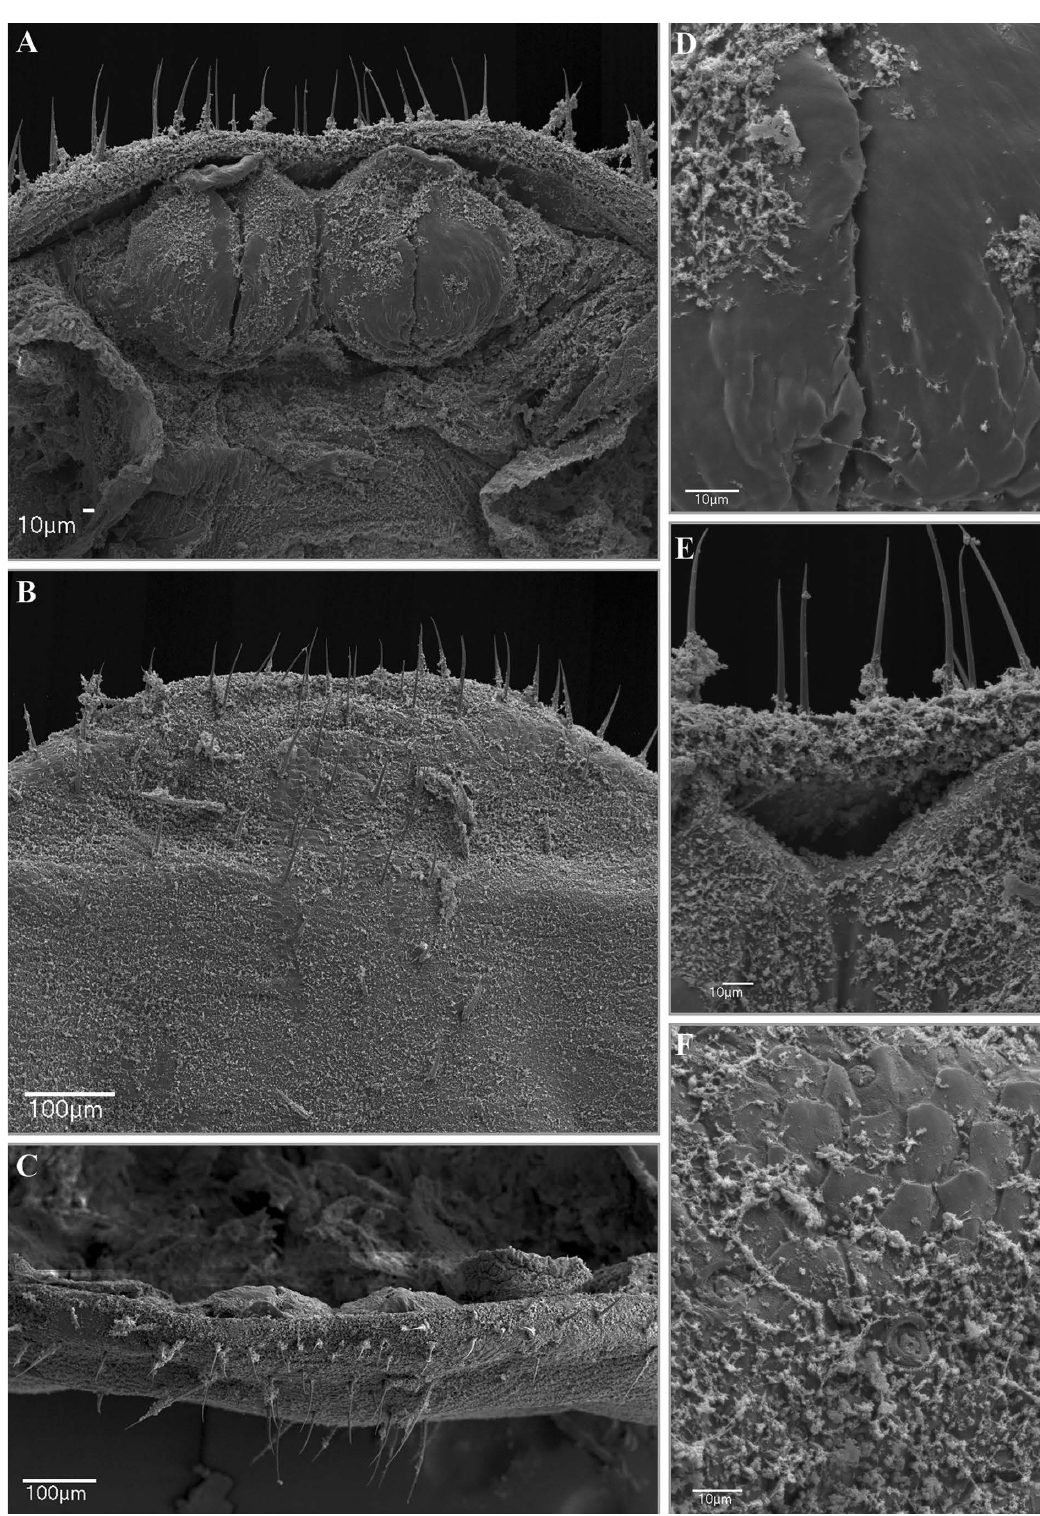
Fig. 14. Charinus aguayoi Moyá-Guzman, 2009 (CarBio), female gonopod and genital operculum. A . Gonopod, dorsal view. B . Genital operculum, ventral view. C . Gonopod and genital operculum, posterior view. D . Dextral gonopod, dorsal view. E . Genital operculum between gonopods, dorsal view. F . Gland on genital operculum, ventral